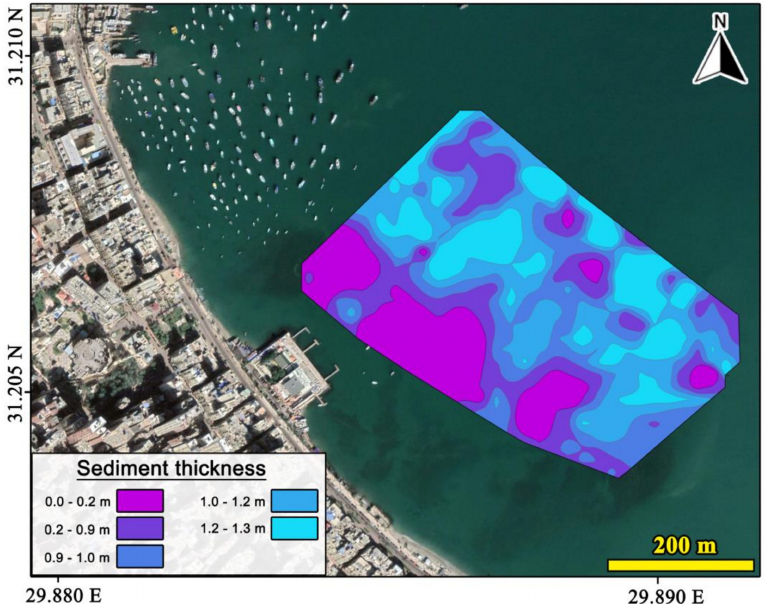
Figure 13. Isopach map for the sedimentation during the Arabic to Recent period in the study